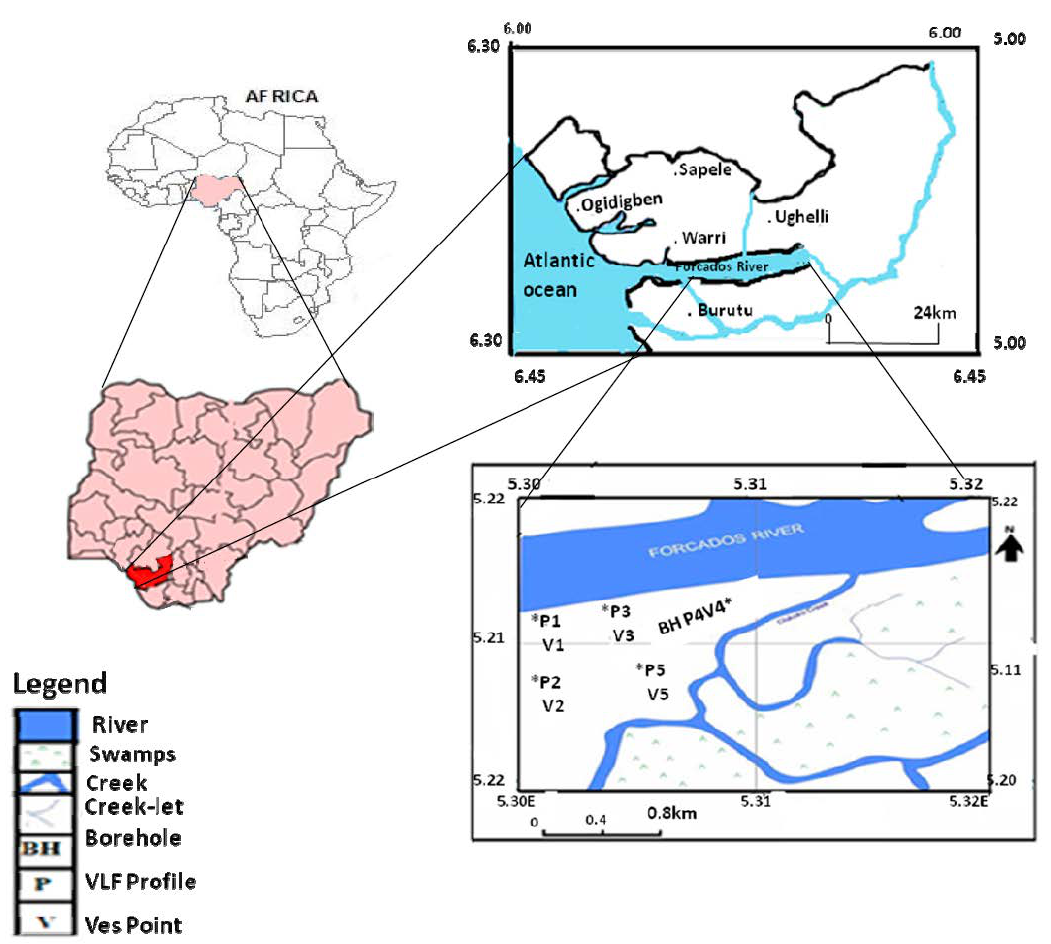
Figure 1. Map of the study location showing VLF, VES and borehole locations (incised are maps of Nigeria and Delta State).